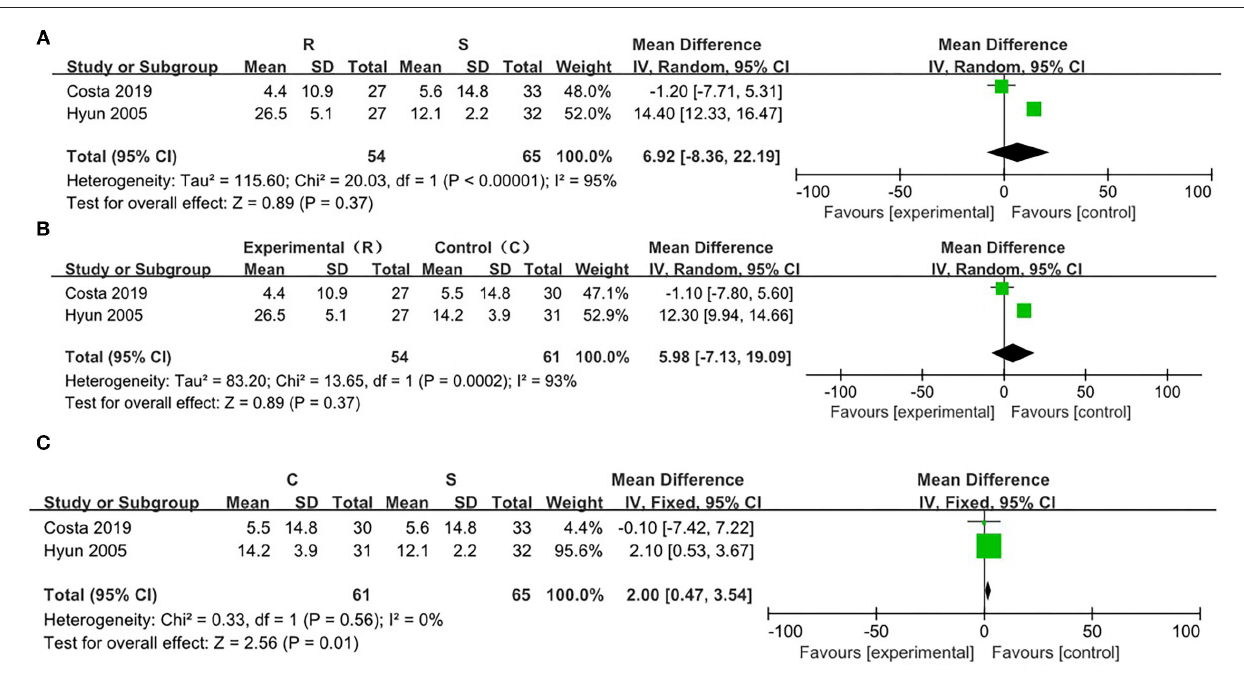
FIGURE 5 | Risk evaluation for the bias of the literatures at T0. (A) CRP vs. SRP; (B) RRP vs SRP; (C) RRP vs. CRP.